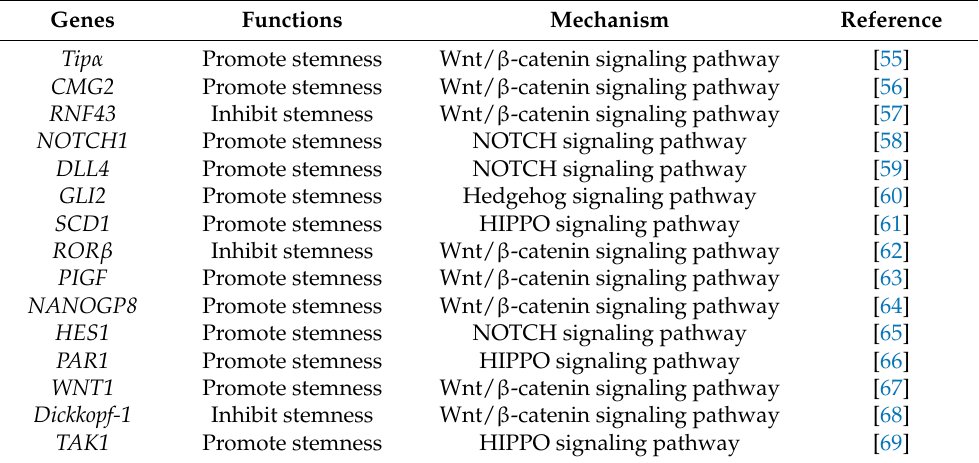
Table 1. Related protein-encoding genes in GCSCs through WNT, NOTCH, Hedgehog, and HIPPO signaling